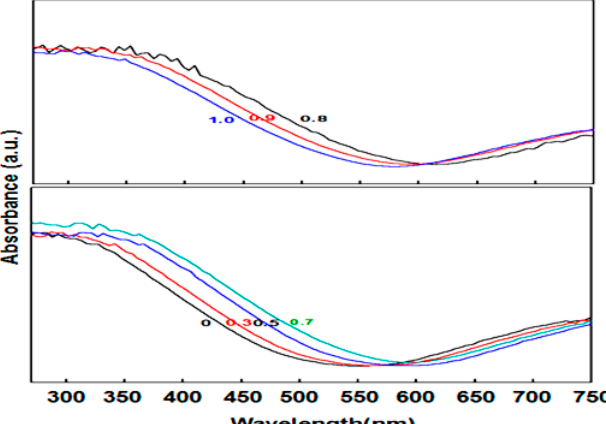
Figure 4. Ultraviolet-visible (UV-vis) diffuse reflectance spectra of different samples.